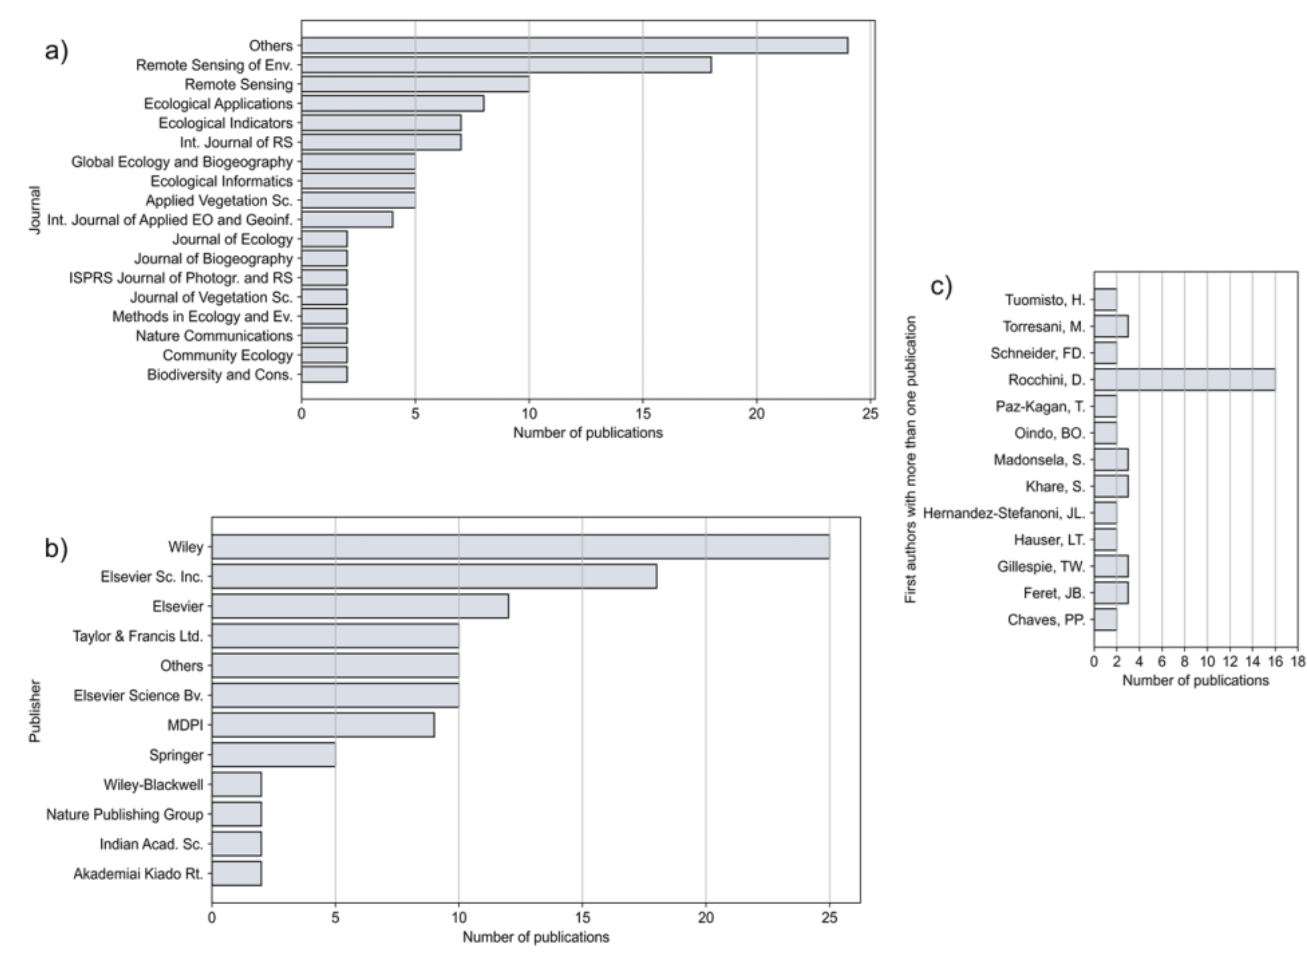
Figure 4. This figure combines information about journals ( a ), publishers ( b ), and most frequent au- thors ( c ). In the plots about publishers and journals, the class “Others” aggregates publishers/journals with a single publication. Similarly, in the plot about the most frequent authors, only first authors with more than one publication are